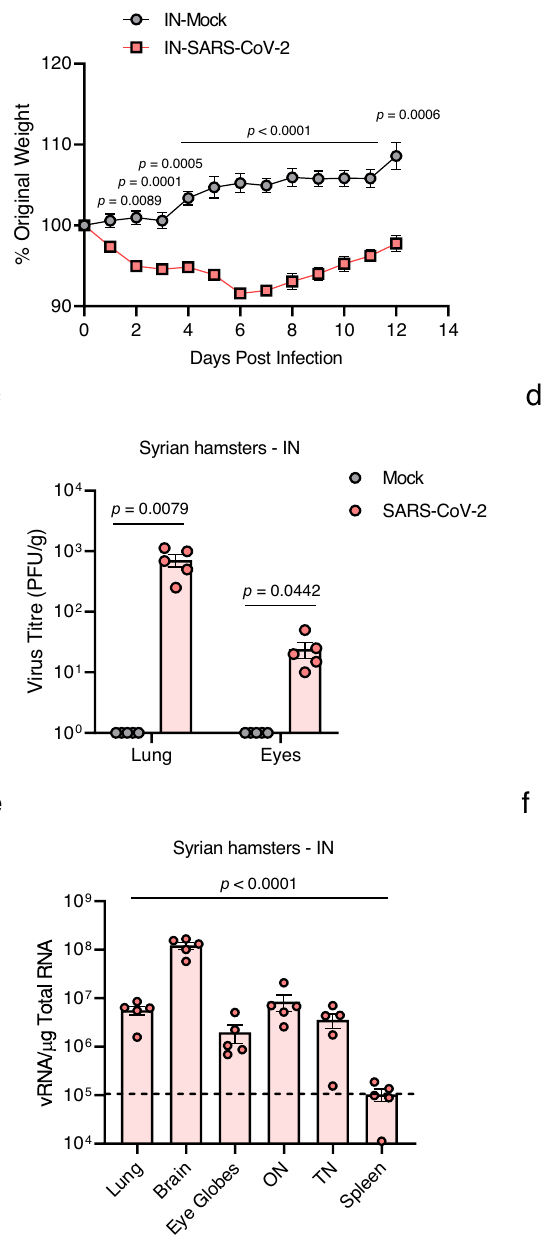
Fig.6|ClinicalfeaturesandviraltitresofSARS-CoV-2inintranasally(IN)oreye- drop (ED)-infected wild-type Syrian hamsters. Eleven-week-old female Golden Syrian hamsters were IN-mock-infected or infected with 10 4 PFU of SARS-CoV-2 ( n =6 formock-infected and n =5 for infected mice; mock, grey; SARS-CoV-2, red). a Body weight changes are shown as the percentage of the starting weight at the indicated dpi after IN infection. b Syrian hamsters were IN- or ED-infected with 10 4 PFU of SARS-CoV-2 (each n =5 for IN-mock-infected, IN-infected, ED-mock-infec- ted, and ED-infected). A graph showing the percent body weight change is shown. c , d Viral loads at 6 dpi in the lungs and eyes of IN-infected ( c ) and ED-infected ( d )